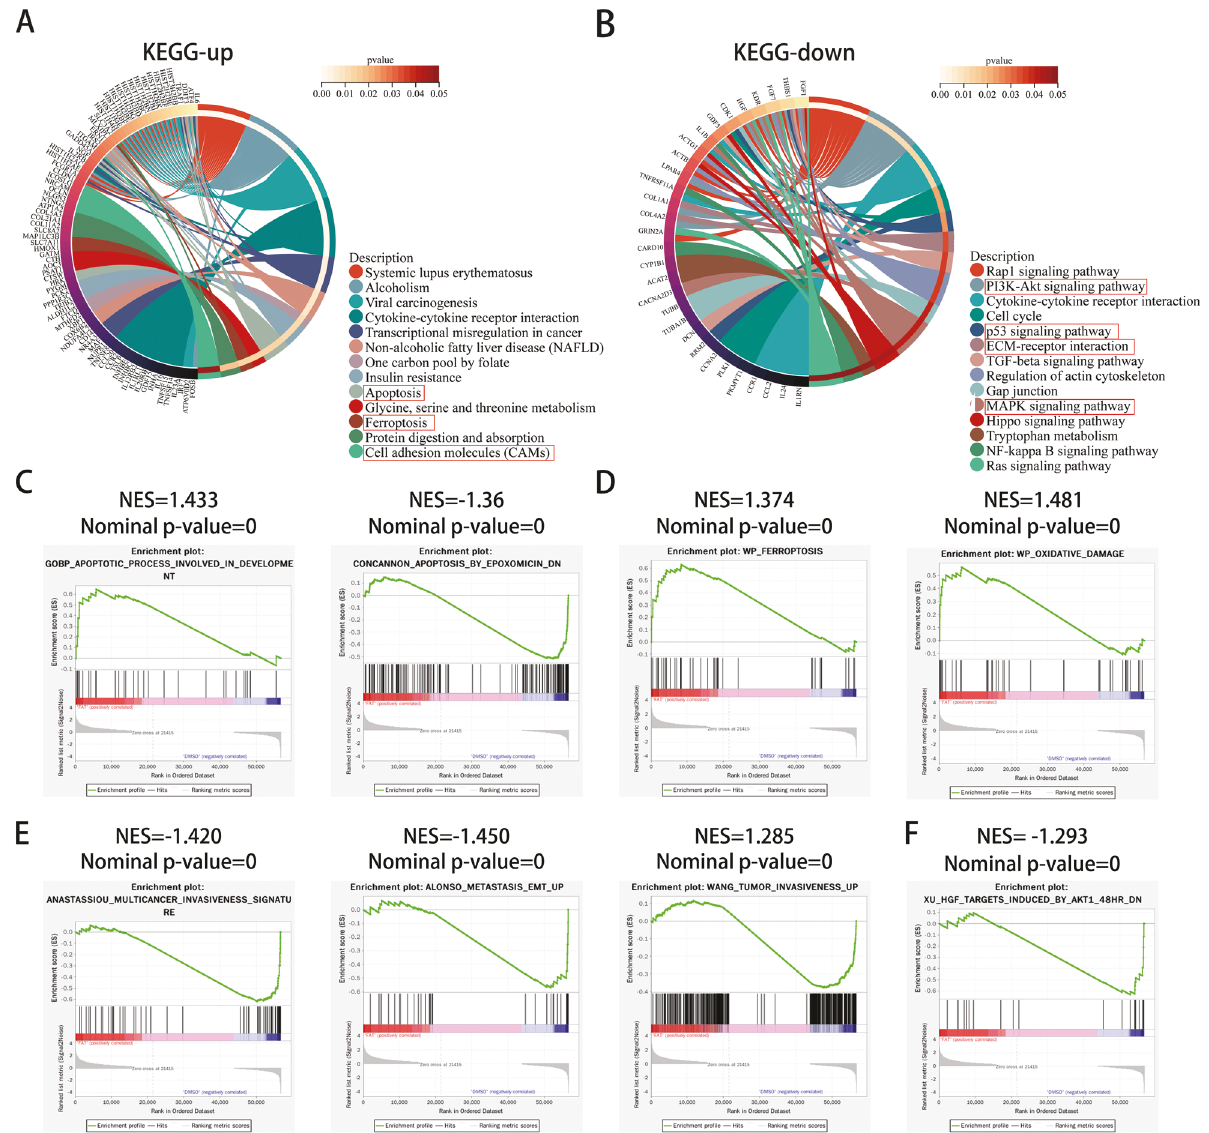
Fig. 2 Functional enrichment analysis of DEGs obtained from RNA-seq. A KEGG enrichment analysis of upregulated DEGs. B KEGG enrichment analysis of downregulated DEGs. The outermost circle on the right represents the term in the lower right corner, and the inner circle on the right represents the P value of the corresponding pathway. C – F GSEA enrichment analysis between the DMSO group and the fatostatin group. NES normalized enrichment score. Fatostatin induces ferroptosis mediated by GPX4 in GBM cells Fatostatin attenuates the EMT process of GBM cells Based on the enrichment analysis results, we further explored the According to the above results, we explored the effect of manner in which fatostatin induces cell death. We used several fatostatin on the migration and invasion of GBM. Through a cell death inhibitors (Z-VAD-FMK, a classic apoptosis inhibitor; wound-healing assay, we found that compared with DMSO, fatostatin signi fi cantly attenuated the migration of U87 and U251 cells (Fig. 3A – D). Similarly, Transwell assays revealed that fatostatin decreased the invasion of GBM cell lines in a dose- dependent manner (Fig. 3E – G). To further explore the role of fatostatin in EMT, we performed Western blotting analysis of mesenchymal-related genes, including E-cadherin, N-cadherin, snail1, and vimentin, in GBM cells. The results showed that the expression of N-cadherin, snail1, and vimentin was decreased in a dose-dependent manner after treatment with fatostatin, while the expression of E-cadherin was upregulated (Fig. 3H, I). These results indicated that fatostatin might attenuate or even reverse the process of EMT in both U87 and U251 cell lines.